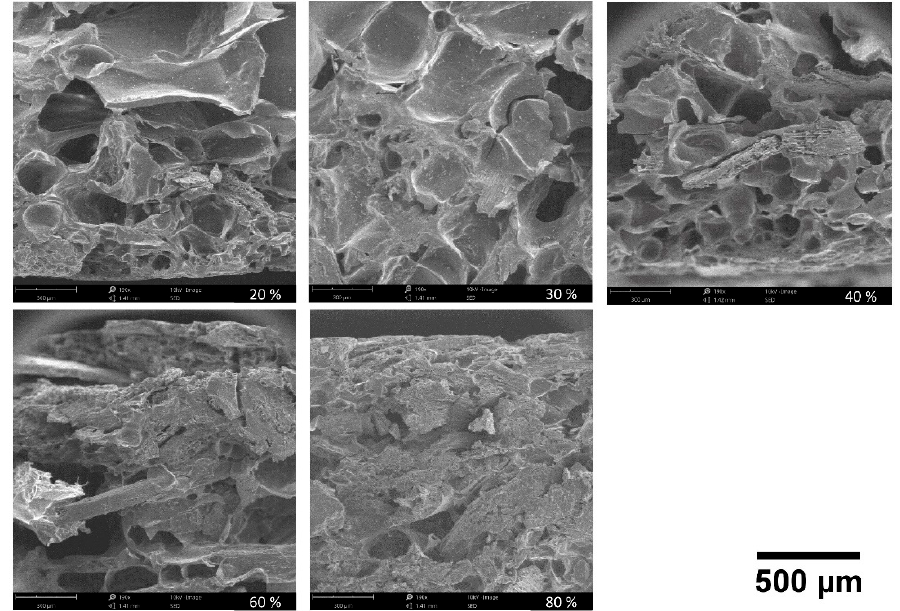
Figure 8. Scanning electron micrographs (190× magnification) for cross-sections of the trays with different BSG contents (20%, 30%, 40%, 60% and 80%).